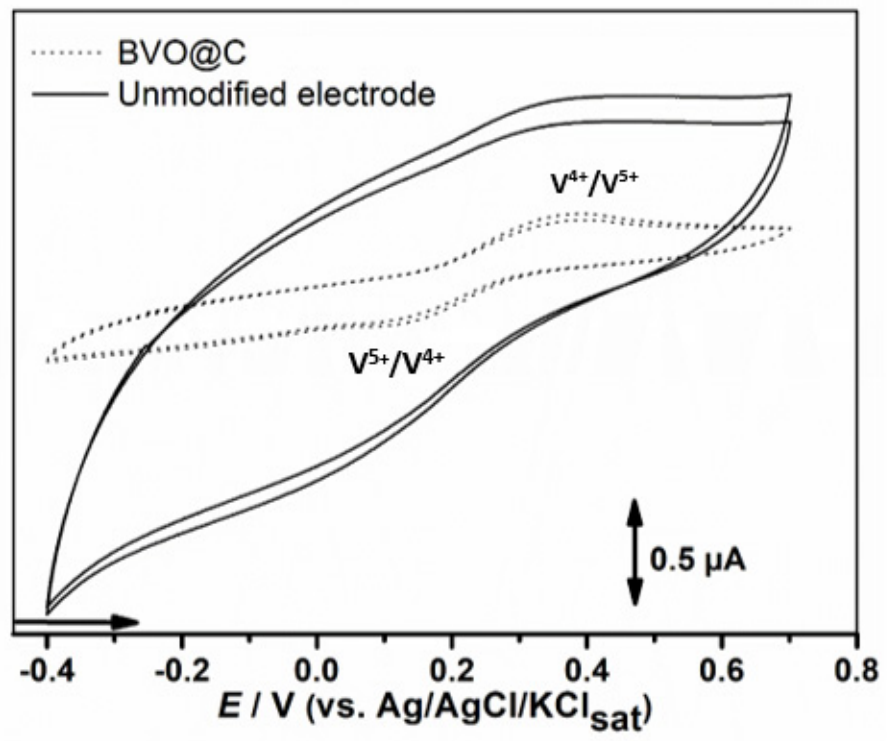
Figure 6. Cyclic voltammograms referring to two successive scans obtained for the different working electrode configurations. Reaction medium is 0.05 mol L − 1 potassium ferrocyanide in 0.05 mol L − 1 KCl.